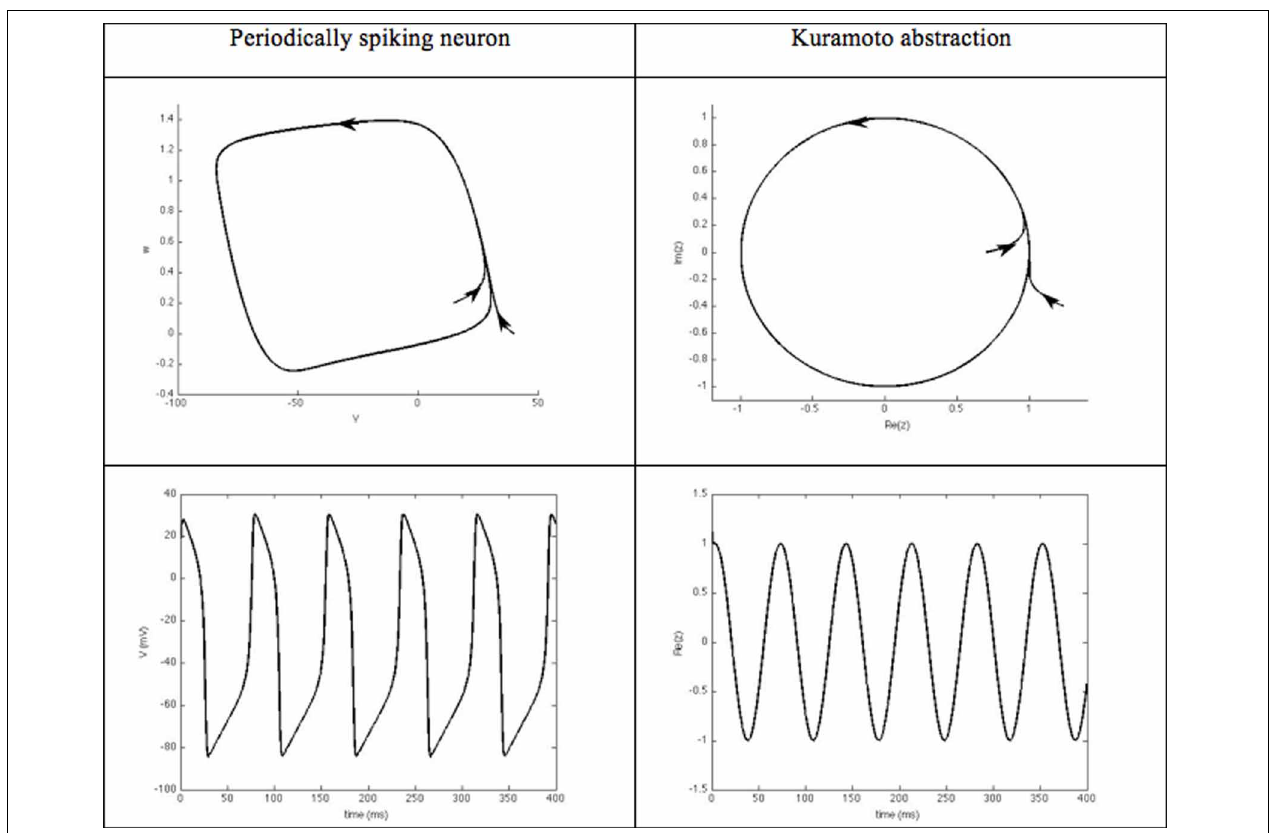
FIGURE 5 | Kuramato oscillator. Periodically spiking neurons are characterized by the existence of an attractive limit cycle in their phase portrait. A classical way to reduce the complexity of analyzing their rhythm is to focus on their instantaneous position along this limit-cycle. Using phase-response curves, this abstraction enables the neuron’s dynamics to be reduced to a single scalar variable, referred to as its phase. Phase models: For periodically spiking neurons whose limit cycle results from a Hopf bifurcation, the limit cycle can be abstracted to a periodic circle. A normal form of the resulting dynamics is known as the Andronov-Hopf oscillator, which is ruled by the complex